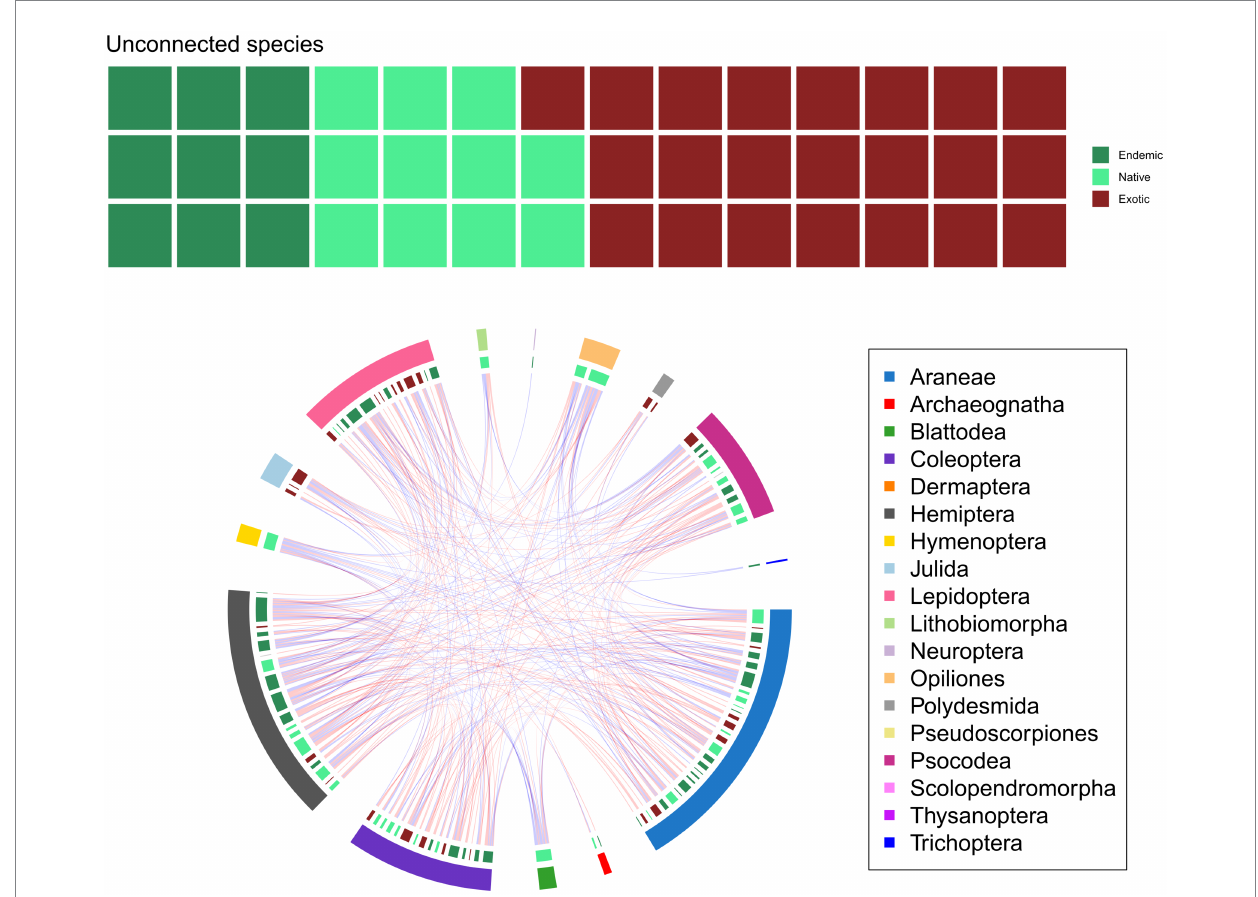
FIGURE 2 The meta-network, colored according to higher taxa and nativity classes (A) , and the number of isolated species, grouped to endemics, natives, exotics, and unknown origins. Each square represents one species. (B) . Red links in the network represent positive, blue links negative associations. Outer arc shows arthropod orders, inner arc the nativity classes. Arc segment length is proportional to the number of nodes the group